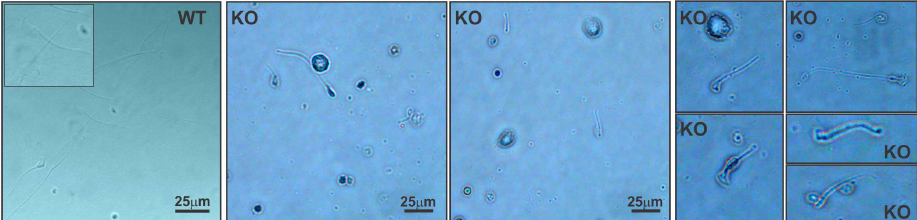
Figure 4. Disruption of the Spag17 gene causes male infertility. Cauda epididymal sperm from Spag17 knockout mice have deformities in the head and tail. WT, wild-type; KO,